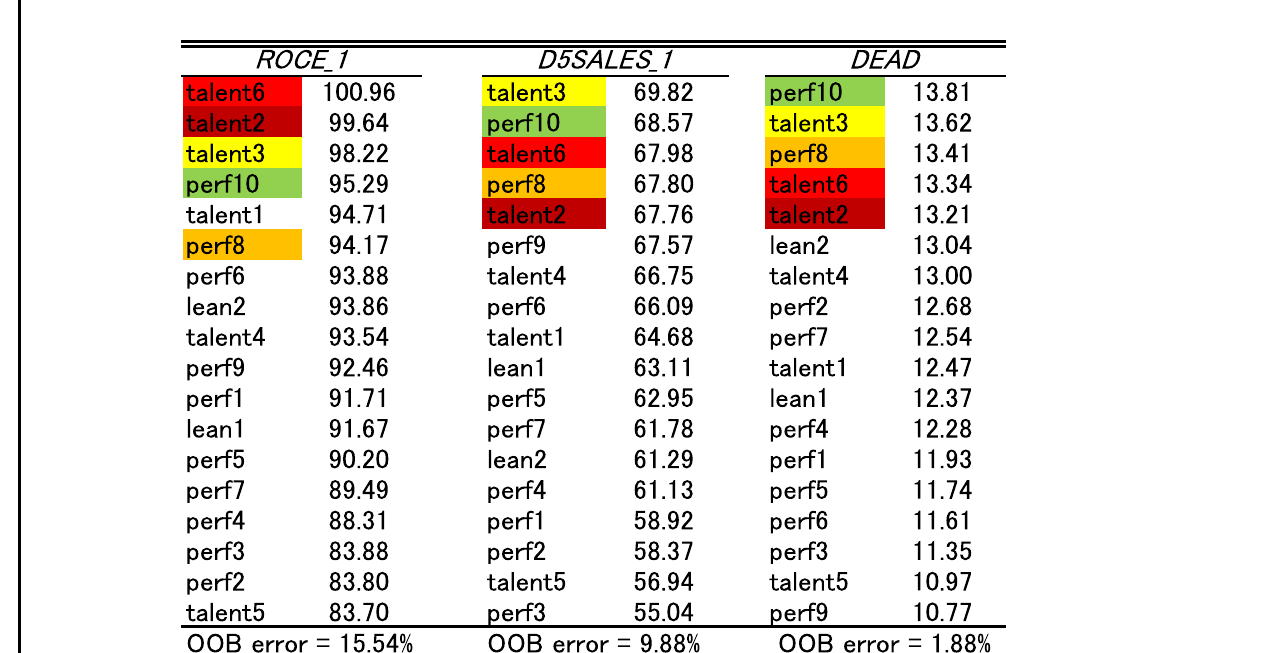
Table 3 Results of RF (sorted from top to bottom in order of